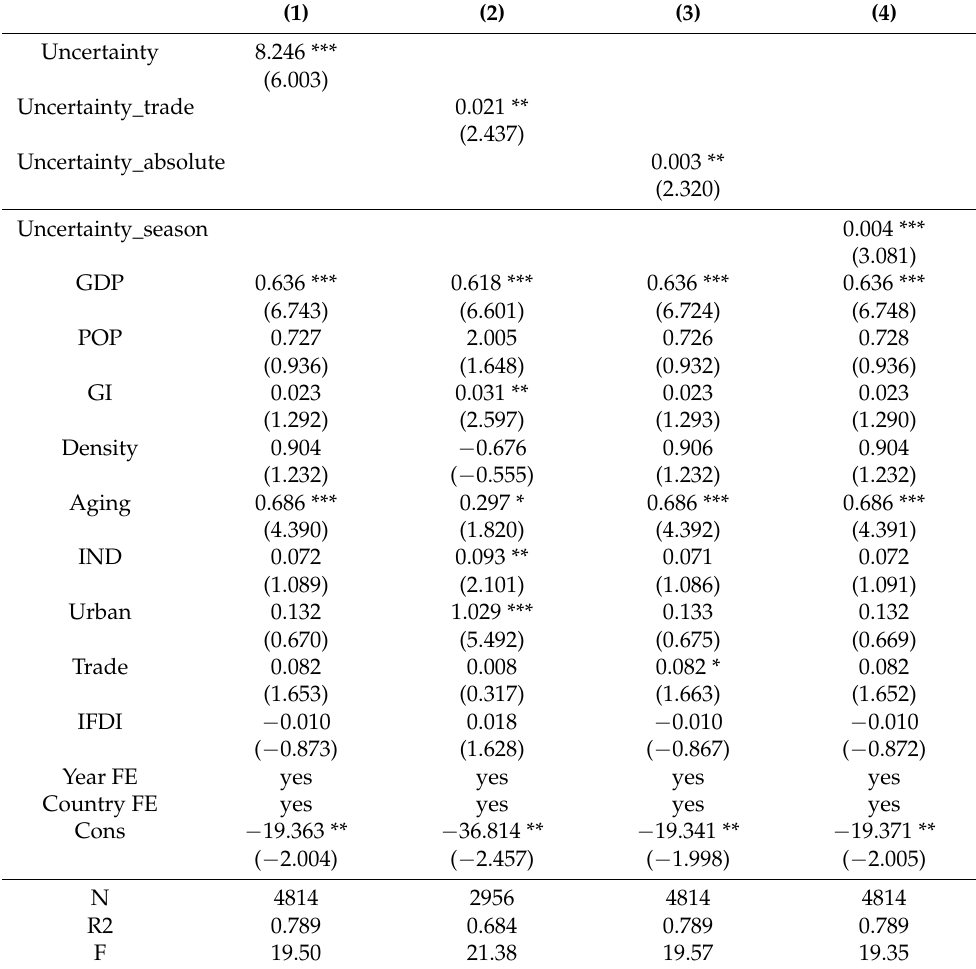
Table 6. Robustness test—changing the estimation.